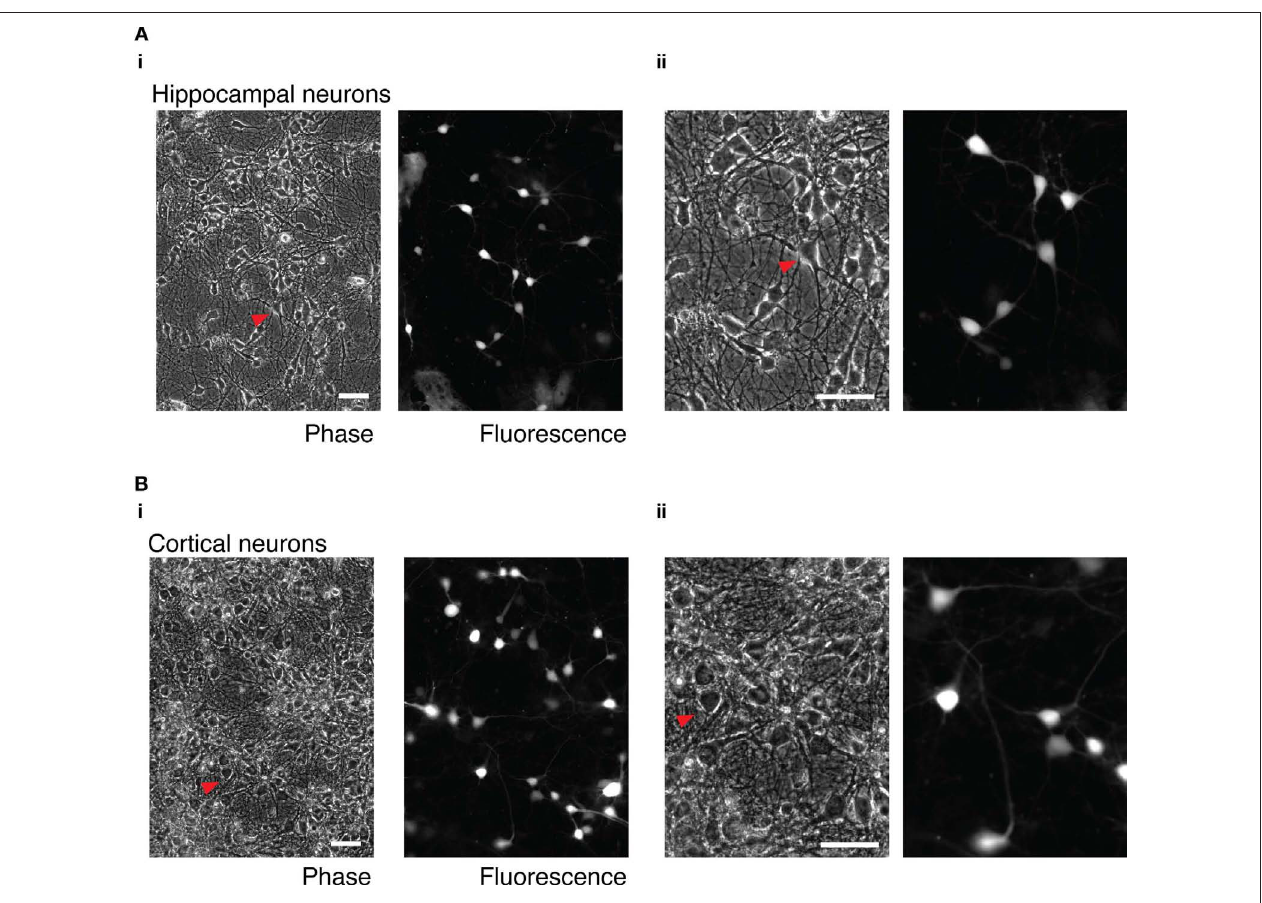
Figure 5 | mrNA transfection of hippocampal and cortical neuron cultures. (A) Cultured, dissociated hippocampal neurons transfected with 3.1 μg GFP mRNA. (i) wide-field phase and fluorescence images. (ii) Enlarged detail of the same images. The red arrow indicates the same transfected neuron in both images.